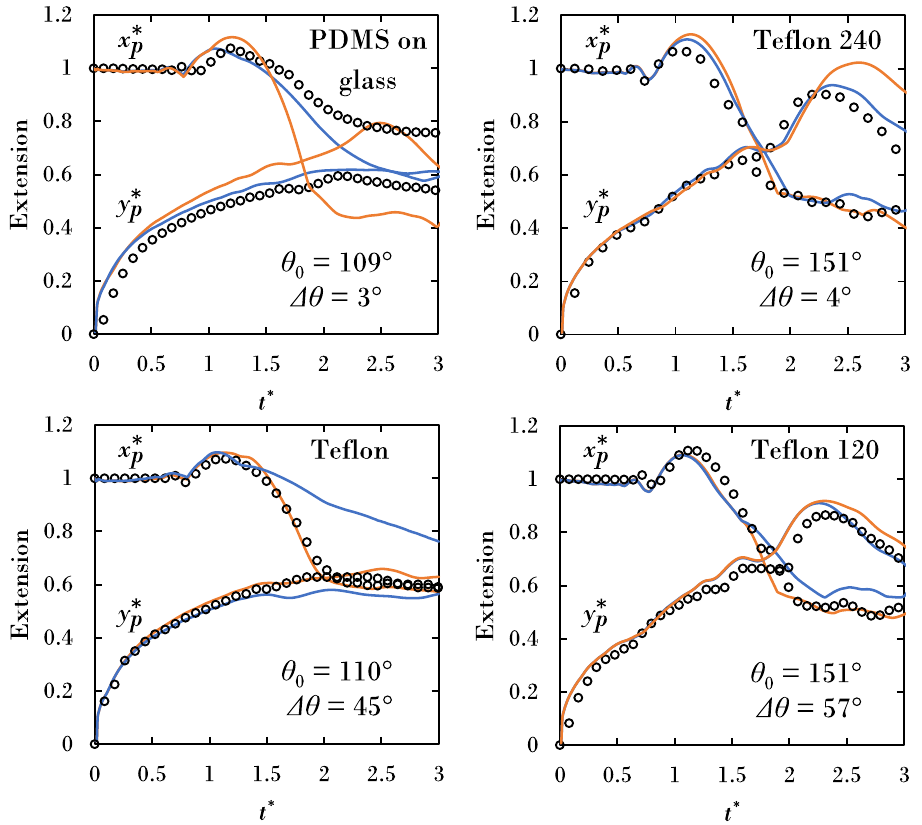
Fig. 6 Time evolution of projected extensions contrasting experiments (open circles) with simulations (solid lines). The Davis – Hocking model is shown in blue line type and the Kistler model in orange line type.